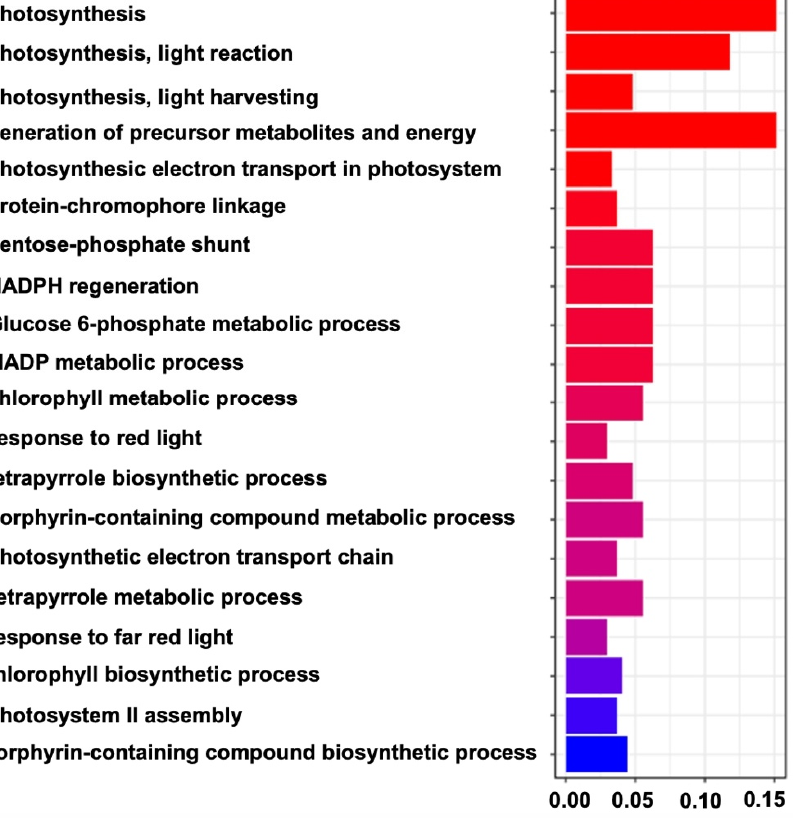
Figure 7. Significant GO terms enriched in the DEGs of the ‘black’ module between the MR-1 and M4-7 stigmas.